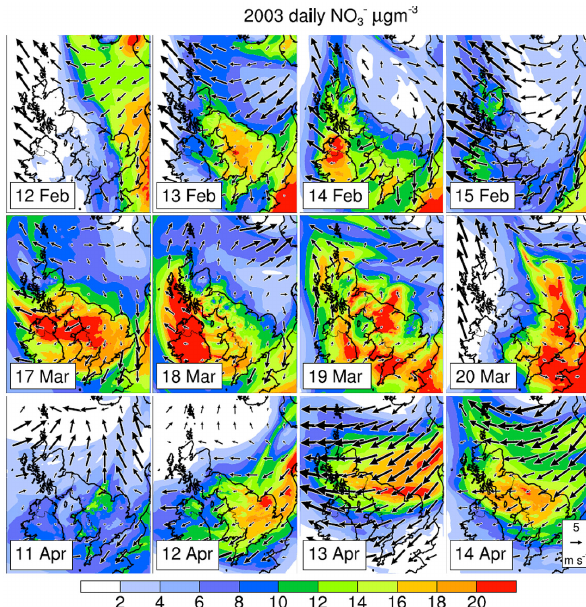
Figure 9. Modelled daily mean surface concentration of NO − the 12:00 wind vector for 12–15 February (episode F), 17–20 March (episode M) and 11–14 April (episode A).